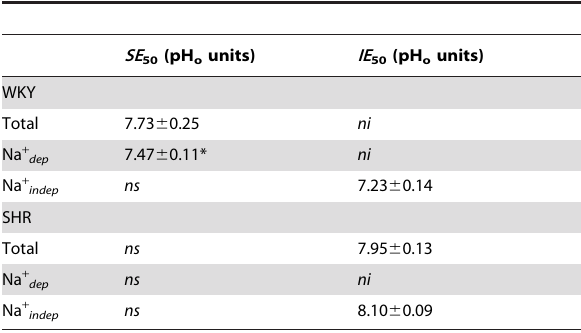
Table 2. Half-maximal effect of extracelular pH on saturable transport of L-carnitine in